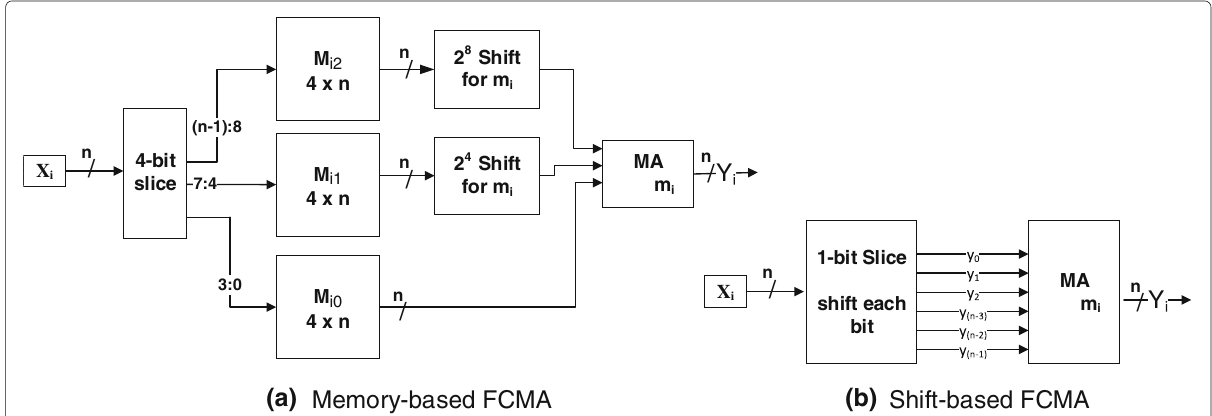
Fig. 8 The proposed FCMA block diagram of the second stage module, which directly performs a residue number multiplication by the filter coefficient at channel q . The M i 0 , M i 1 and M i 2 blocks are identical memories of 4 × n and contain values of m i ∗ 2 z ∗ h k ∗ j , where h k is the k th filter tap and j ∈ [0,16]. ( a ) Using memories. ( b ) Using shift operators and